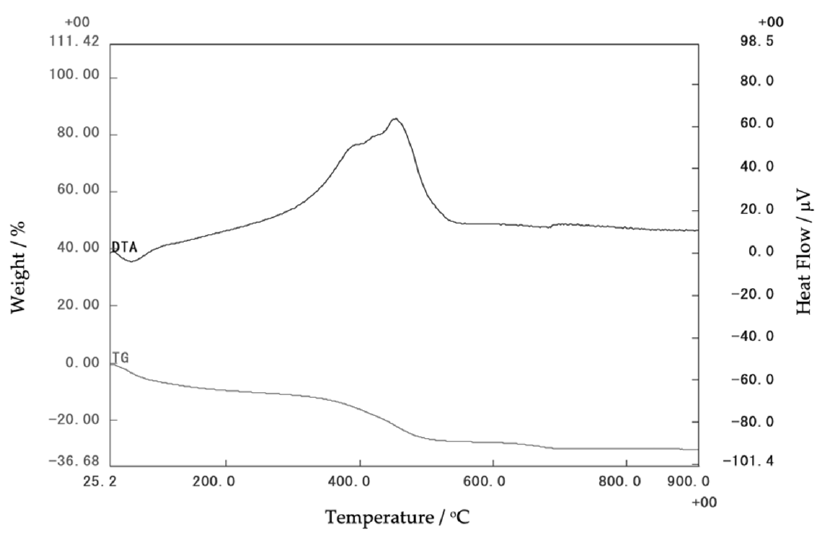
Figure 7. Thermogravimetric analysis of corn stover ash.